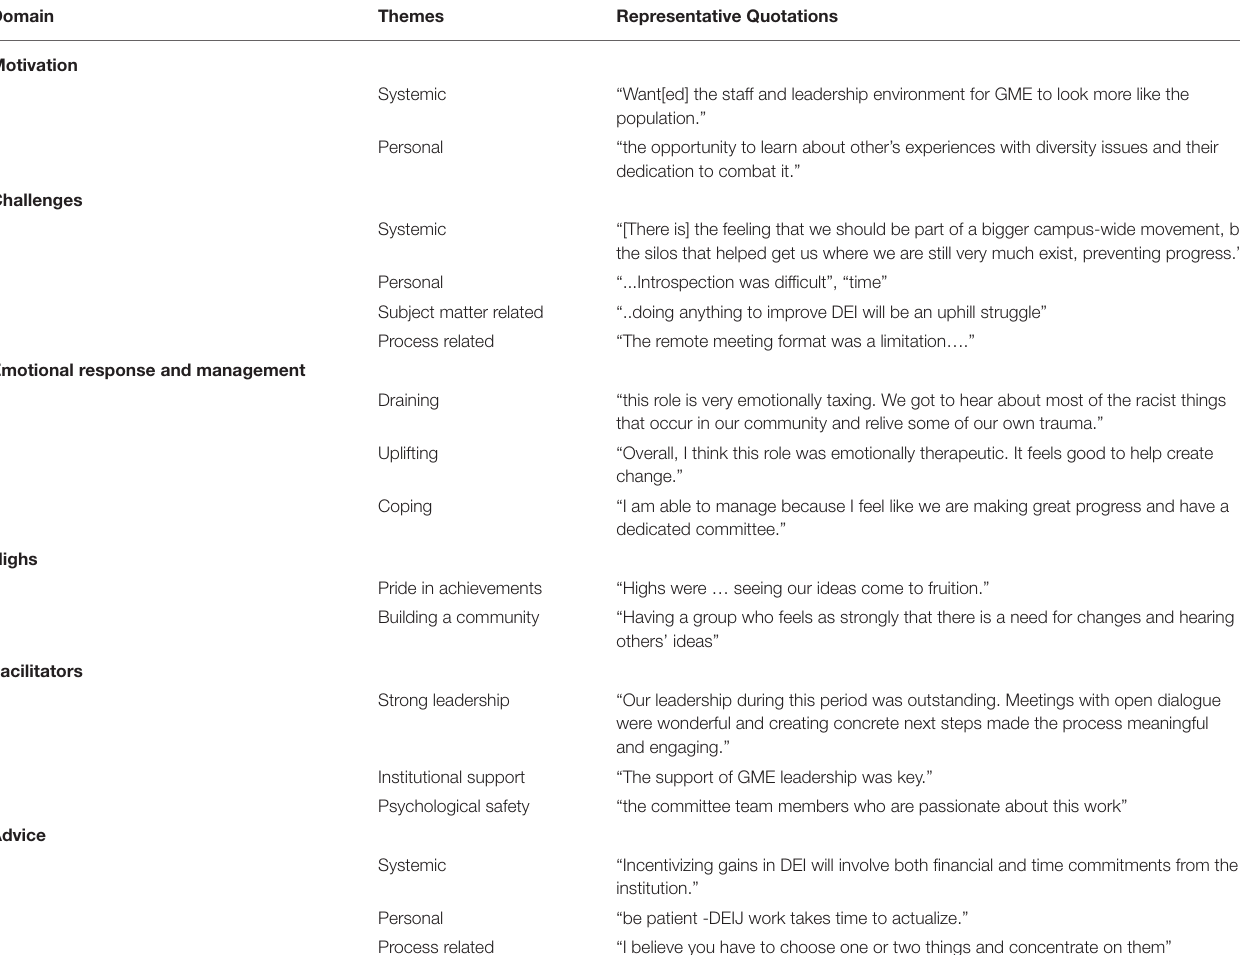
TABLE 2 | Domains, themes and representative quotes emerging from